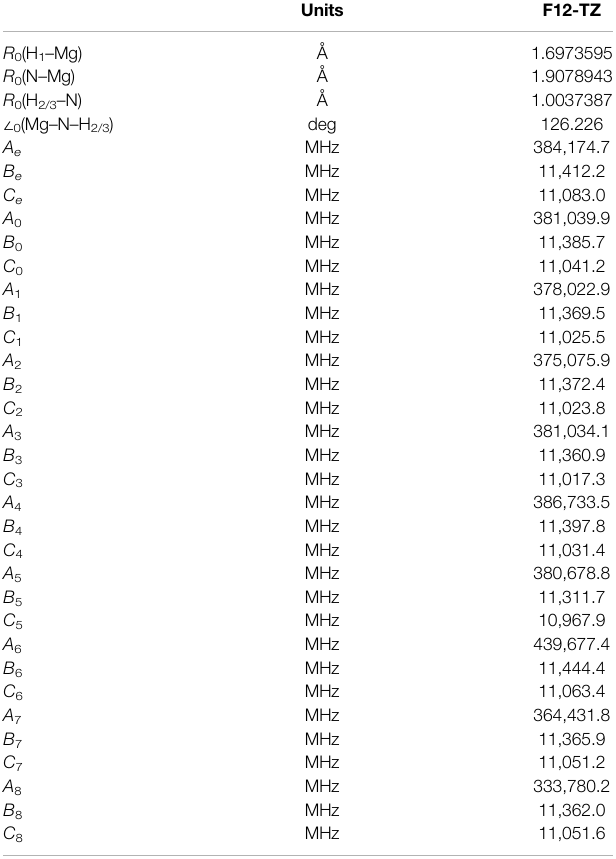
TABLE 6 | Geometry and rotational constants for HMgNH 2 .